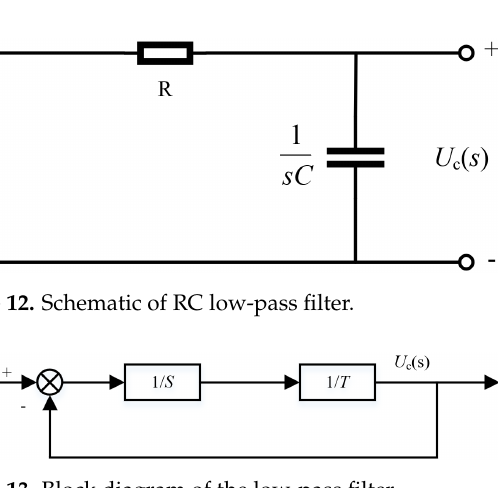
Figure 13. Block diagram of the low-pass